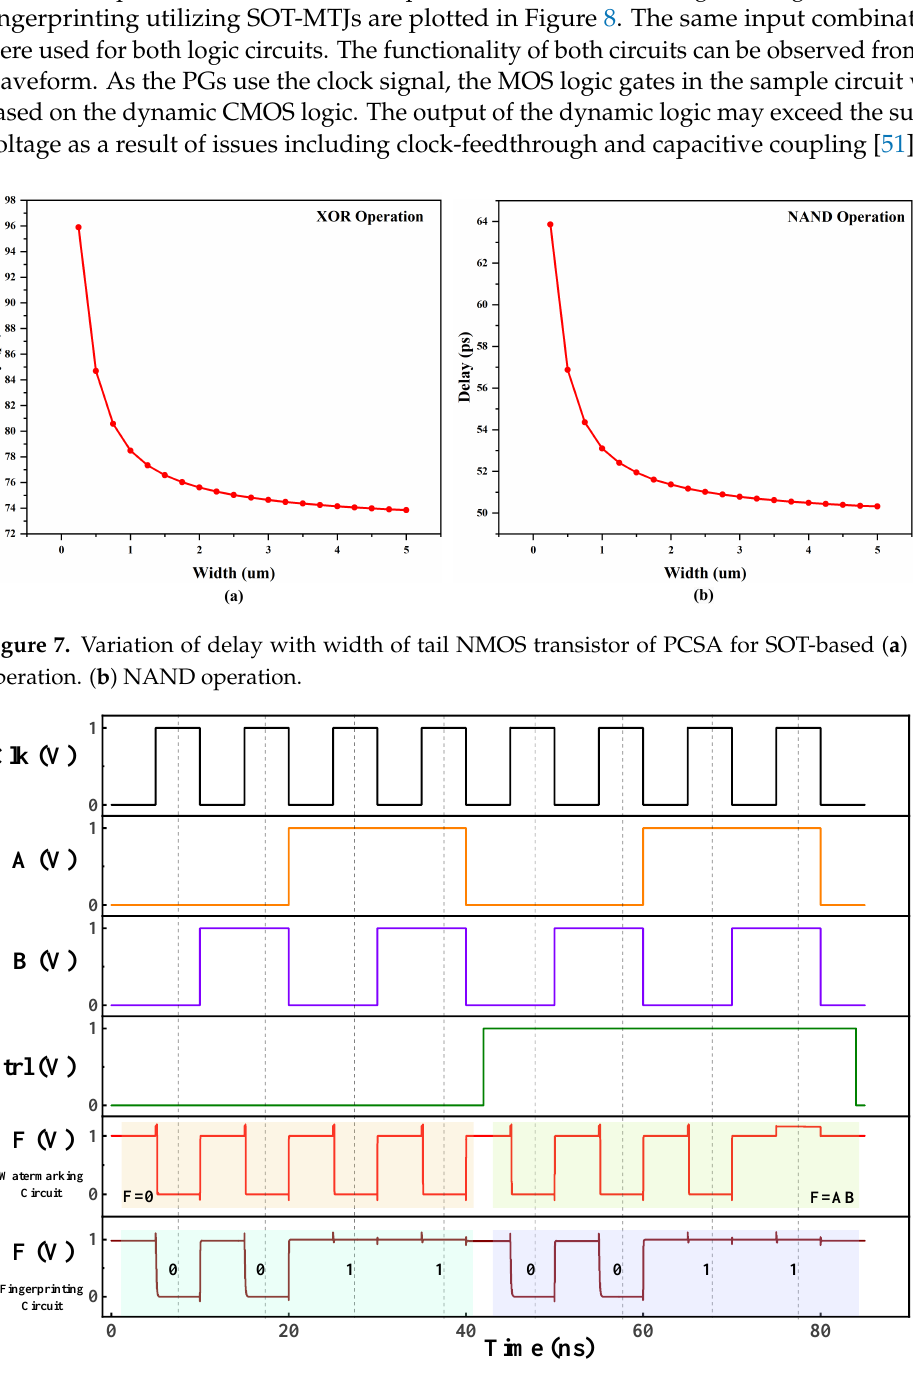
Figure 8. Waveform showing the operation of spintronics PG based watermarking and fingerprinting example